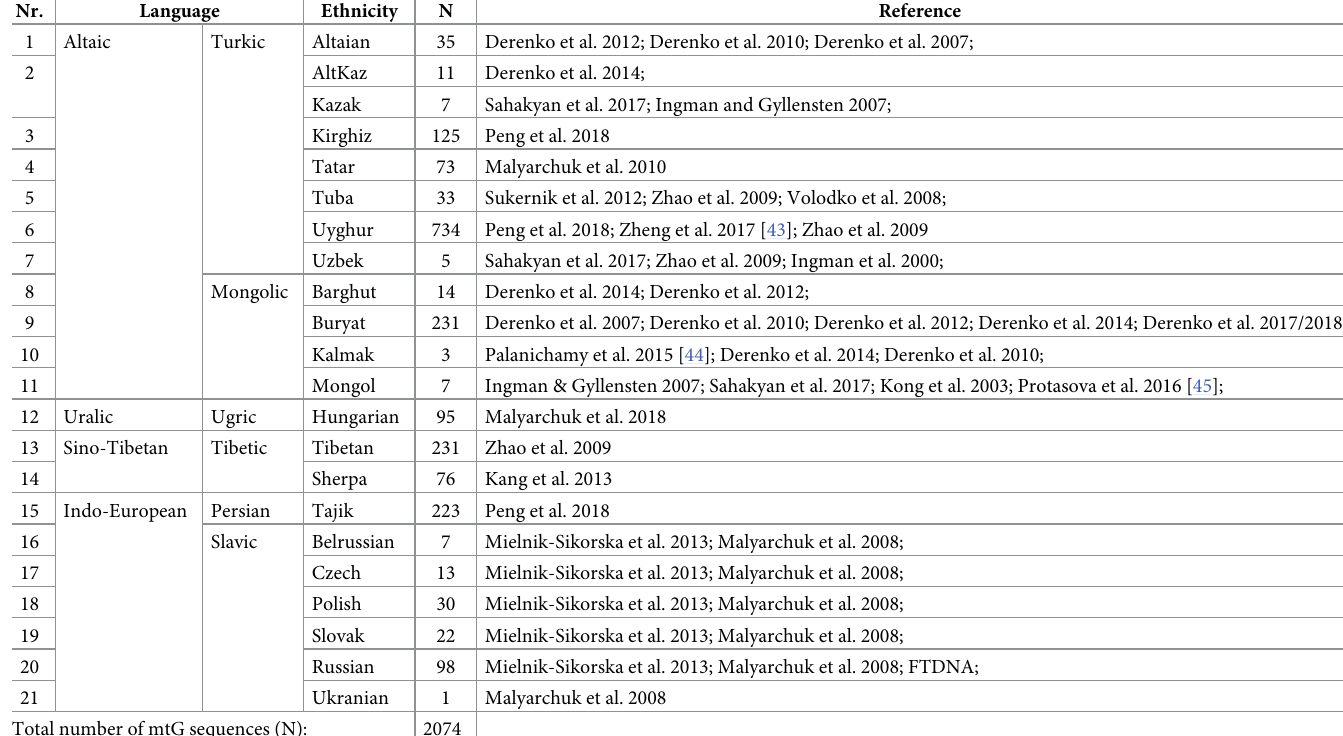
Table 3. Information on whole mitochondrial genome sequences which used for comparison.